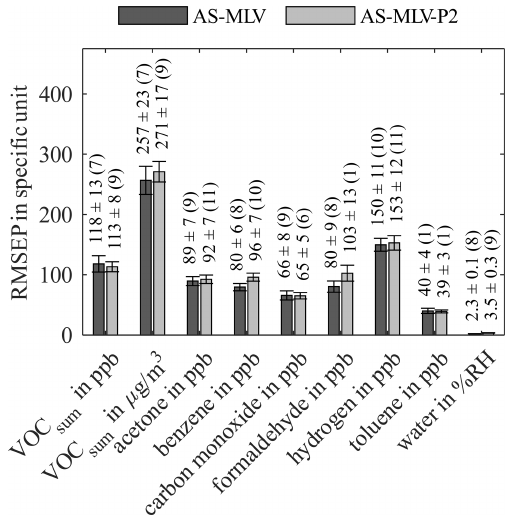
Figure 6. Root-mean-square error of prediction (RMSEP) for AS- MLV and AS-MLV-P2 for different models. Calculation of the regression model with the complete dataset with 10-fold nested cross-validation for hyperparameter optimization (PLSR compo- nents) and testing. The number of PLSR components, determined with Eq. (2), is given in parentheses.